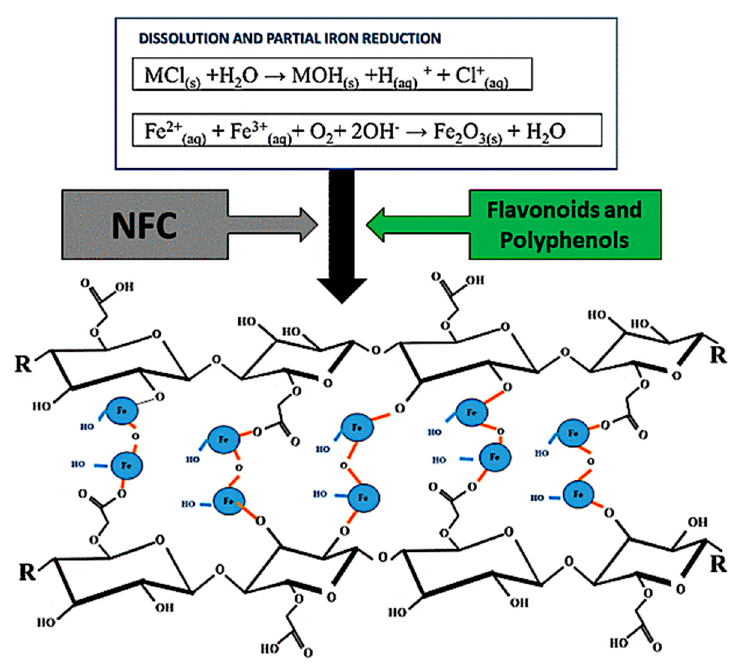
Figure 13. Schematic diagram of iron nanoparticle formation.